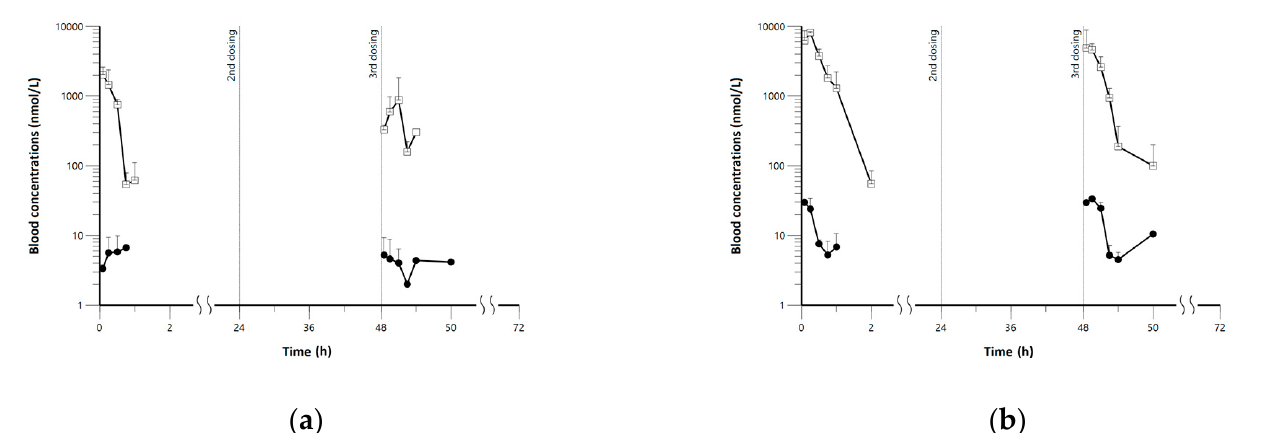
Figure 3. Blood concentrations for artesunate and dihydroartemisinin after multiple dosing of ( a ) low-dose (60 mg/kg) and ( b ) high-dose (120 mg/kg) artesunate to hamsters. Closed circles and open squares are blood concentrations of artesunate and dihydroartemisinin, respectively.